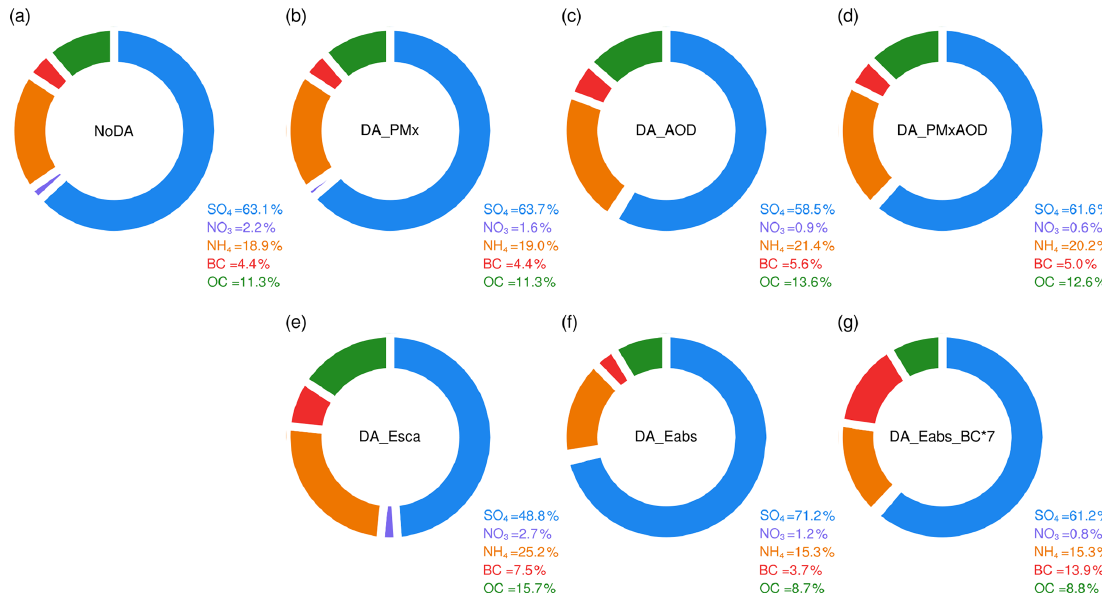
Figure 12. Mean mass percentage (%) of chemical composition in PM 10 excluding the OIN component at Kashi in April